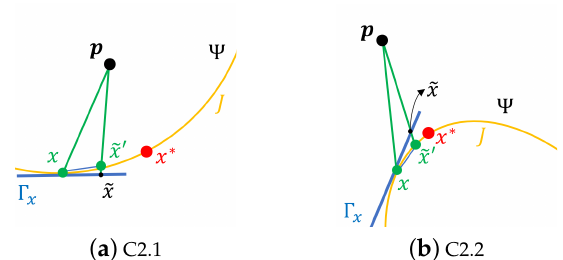
Figure A2. The 2 cases of C2. For any point x on J , there exists a point ˜ x (cid:48) ∈ J associated to ˜ x which on the tangent plane Γ x to Ψ at x , for α ∈ [ 0,1 ] , such that ( a ) Ψ (cid:16) (cid:17) Ψ ( p ) ≤ α x + ( 1 − α ) ˜ x (cid:48) ( b ) Ψ